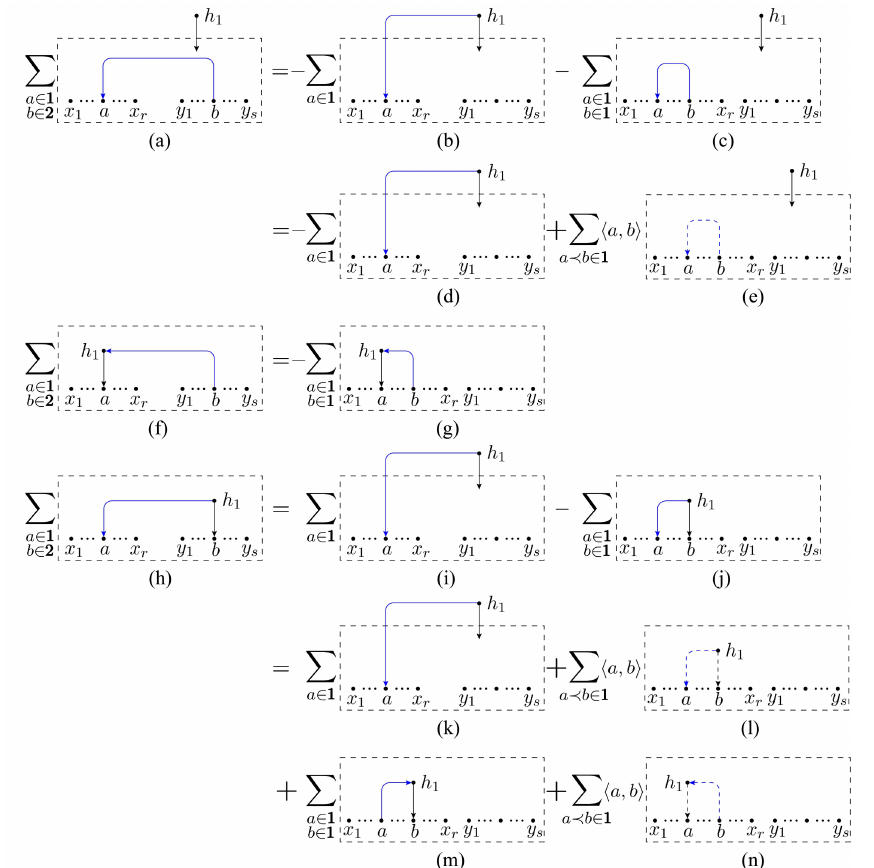
Figure 16 . Transformations of spanning forests for one-graviton ( g − , g − )